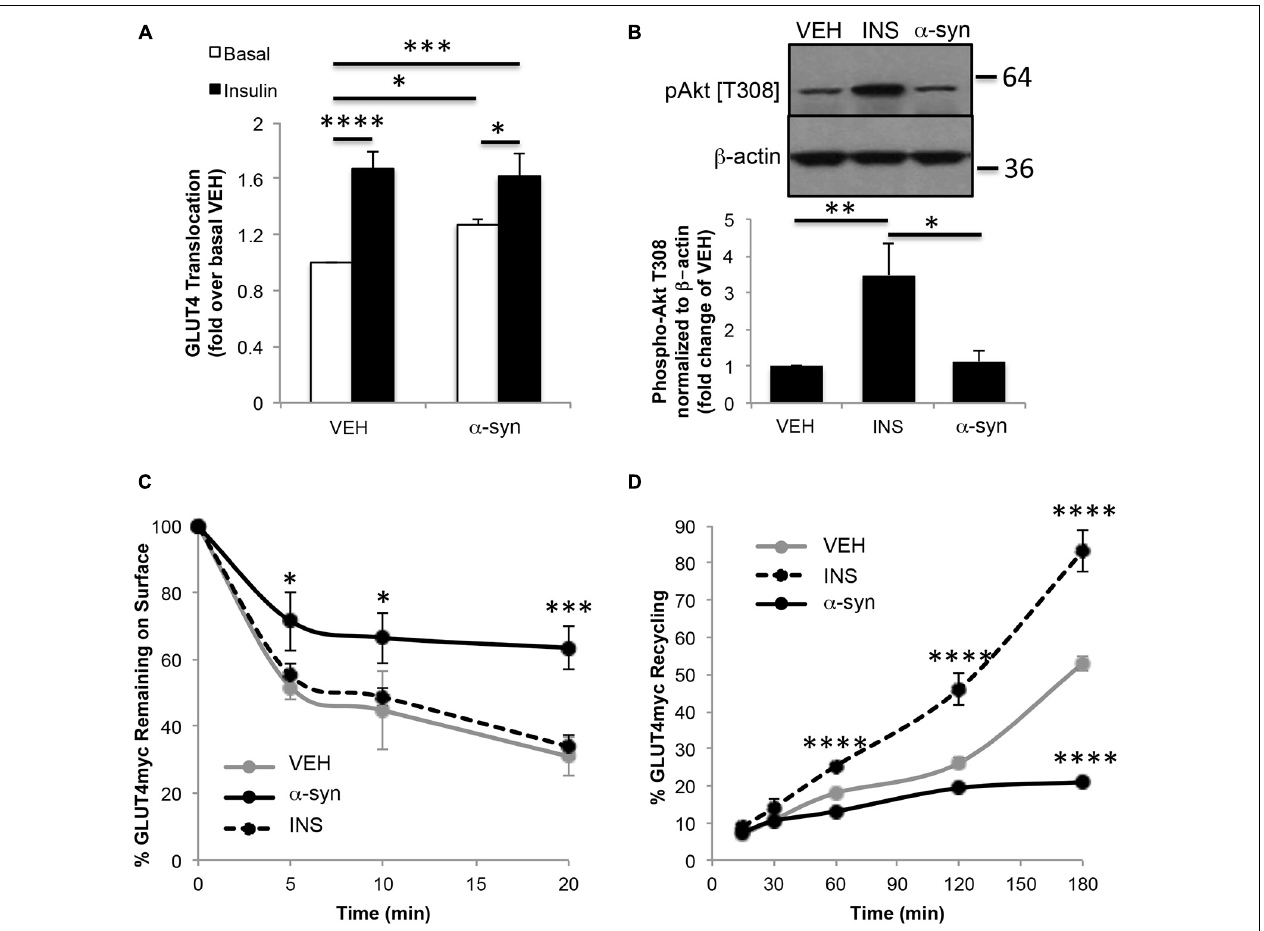
FIGURE 4 | In vitro α -syn monomer treatment increases cell surface GLUT4 levels. (A) Surface GLUT4 myc levels ( n = 4–7), (B) Akt phosphorylation ( n = 4), (C) GLUT4 myc endocytosis ( n = 4) and (D) GLUT4 myc exocytosis ( n = 3) in GLUT4 myc L6 myotubes treated with vehicle, 100 nM insulin or 1.68 µ g/mL α -syn monomers as described in Materials and Methods ( ∗ p < 0.05, ∗∗∗ p < 0.001, ∗∗∗∗ p <